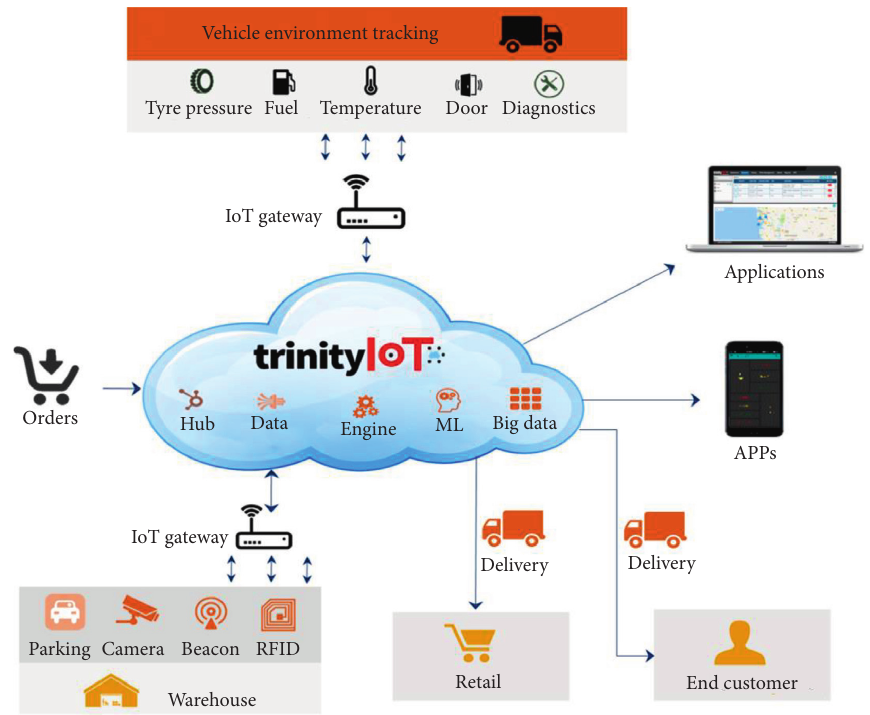
Figure 1: Interface diagram of logistics route optimization software.